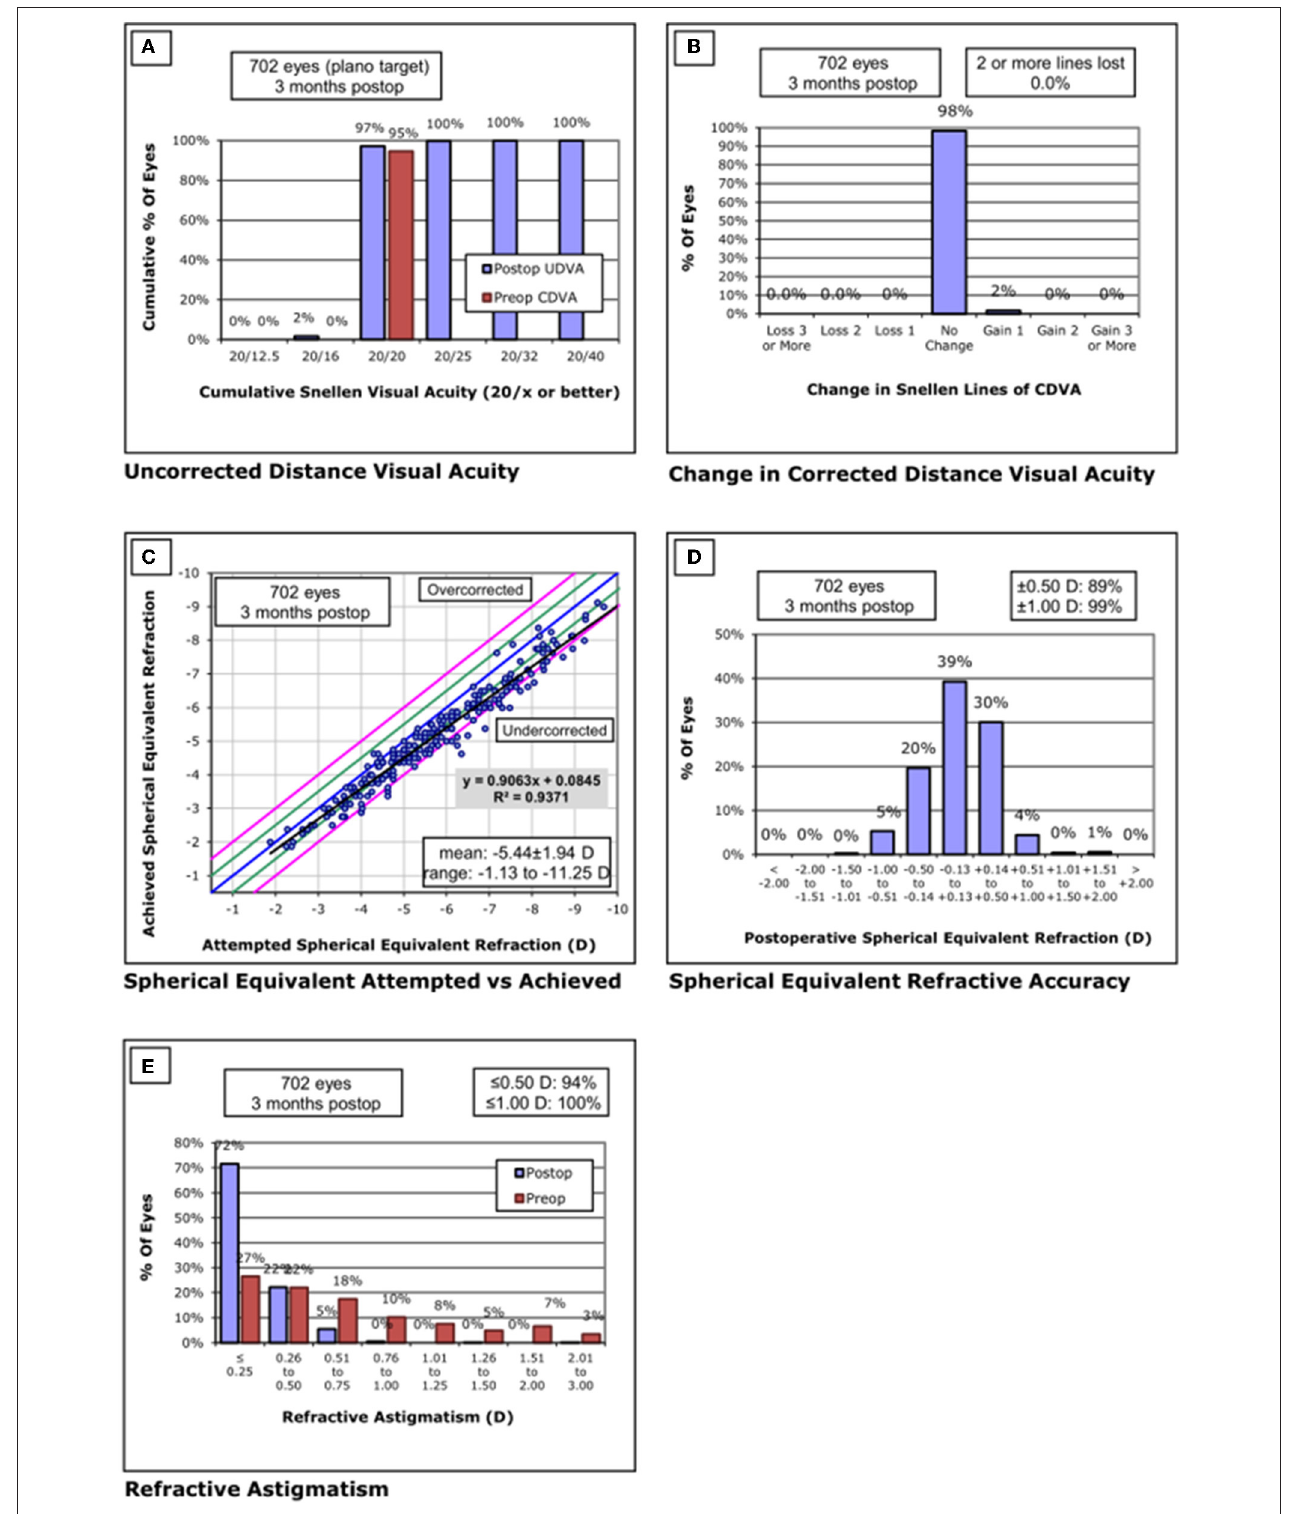
FIGURE 3 | Standard graphs of refractive surgery visual and refractive outcomes for 702 eyes at 3 months post-SMILE in center B. (A) Uncorrected distance visual acuity. (B) Change in corrected distance visual acuity. (C) Spherical equivalent attempted vs. achieved. (D) Spherical equivalent refractive accuracy. (E) Refractive astigmatism. SMILE, small-incision lenticule